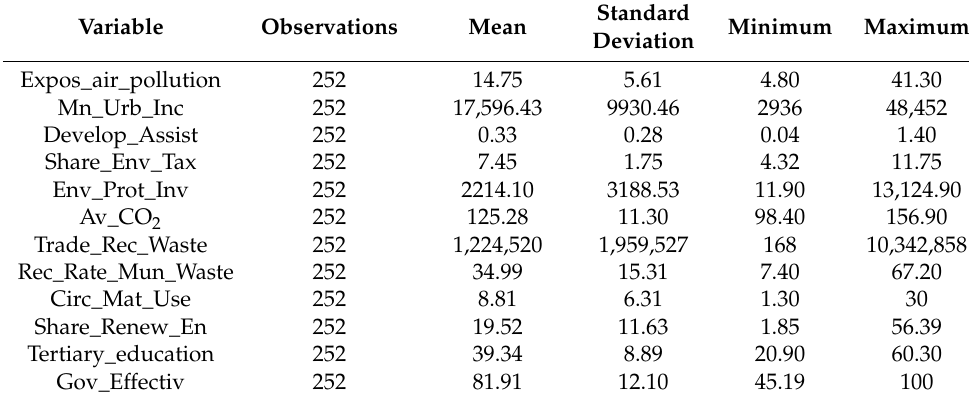
Table 3. Descriptive statistics for total EU28